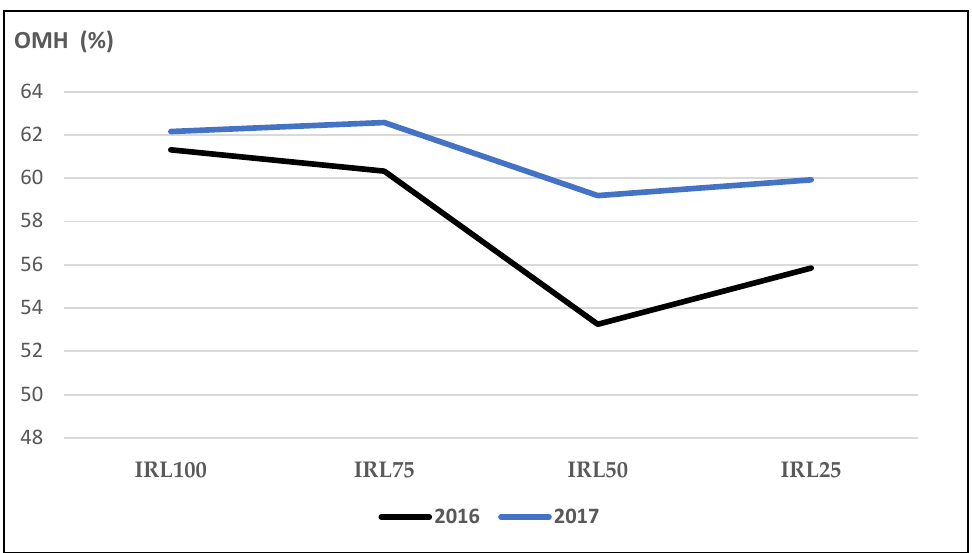
100 and IRL 75 were higher than IRL 50 and IRL 25 (Figure 3).